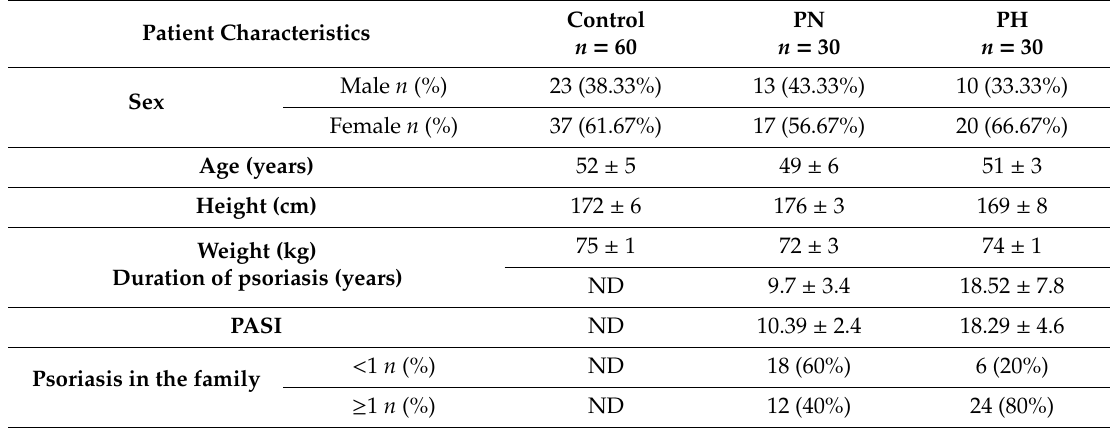
Table 1. Clinical characteristics of plaque psoriasis patients and control